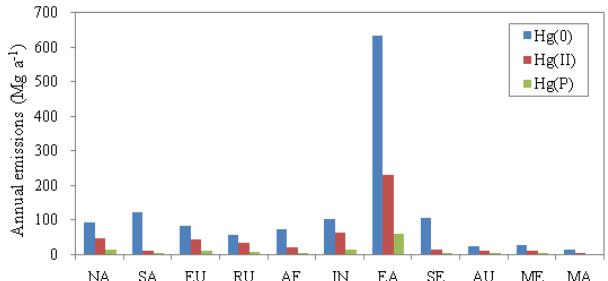
Figure 2. Tagged regional anthropogenic mercury